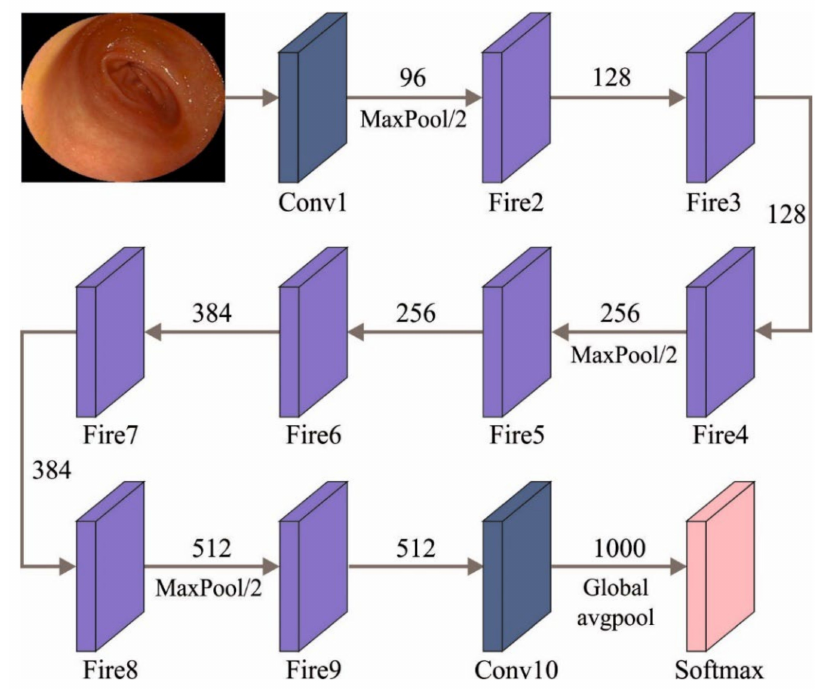
Figure 2. Structure of SqueezeNet